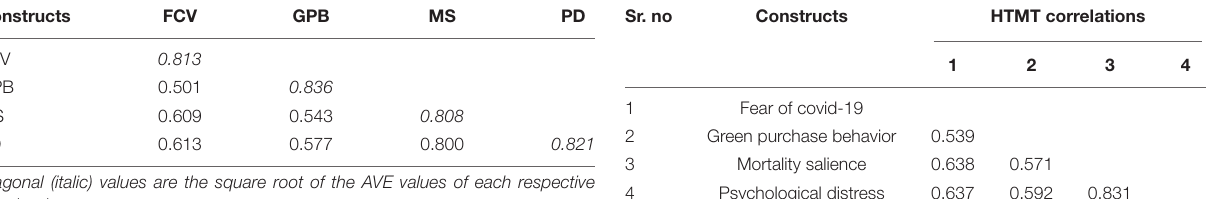
TABLE 5 | Discriminant validity—Heterotait-Monotrait (HTMT) ratio. Sr.